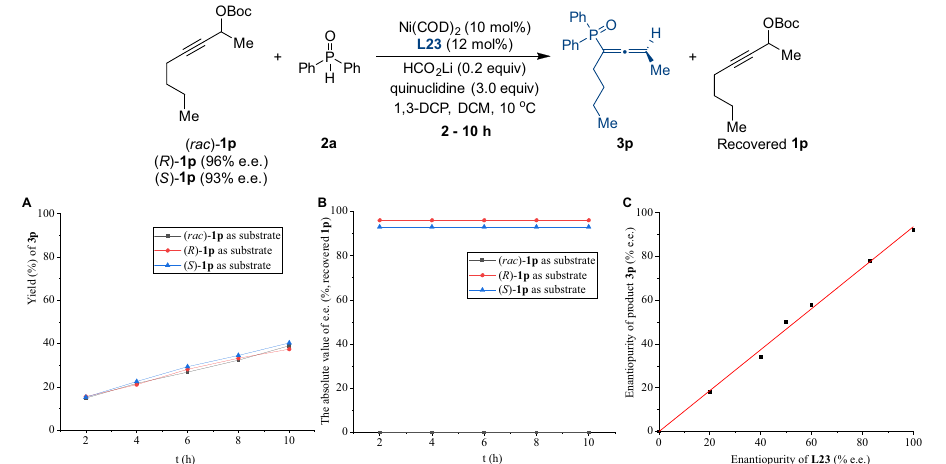
Fig.6|Mechanisticstudies.A Timecourseofthekineticresolutionof 1p . B e.e.ofrecovered 1p atpartialconversion. C Nonlinearrelationshipbetweentheenantiopurity of phosphine ligand L23 and adduct 3p .